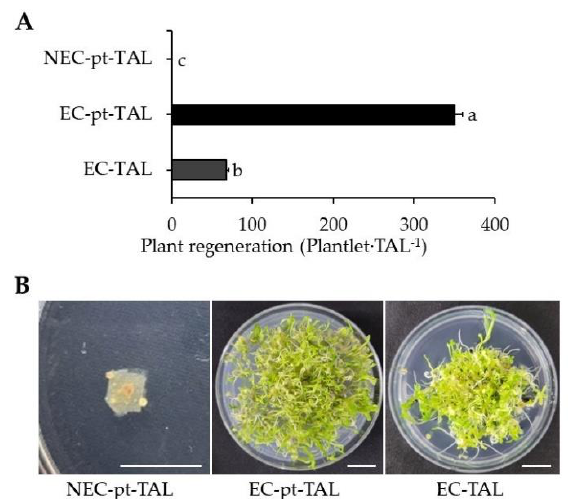
Figure 5. Plant regeneration from EC/NEC-pt-TAL and EC-TAL: ( A ) number of regenerated plants from TAL fragments; ( B ) images of plants regenerated from TAL fragments in the Petri dish. White scale bar = 1 cm.